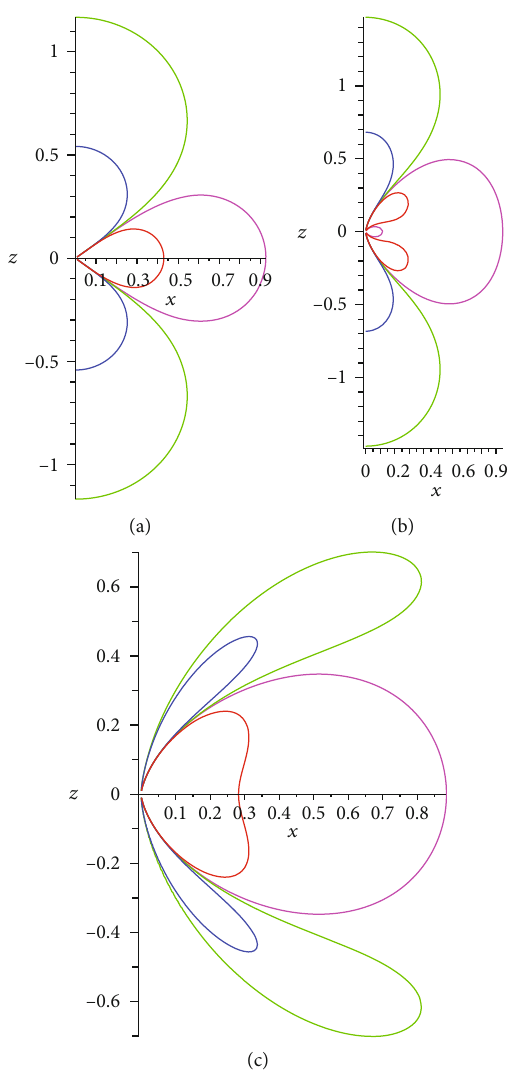
Figure 3: Contours of revolution surfaces around the vertical axis of constant charge density measured in the reference frame at rest with the vertical axis, on the left for a rigid rotating magnetic dipole (Equation (56)); the cases of di ff erential rotation are shown on the center and left, respectively, for charge densities (Equations (59) and (62)). The green curve corresponds to ρ = − 1 , blue is for ρ = − 10 , red for ρ = +10 , and magenta for ρ = +1 . These examples suggest that magnetospheres around astrophysical objects may be quite diverse. Figures were plotted using a = 1 , k = 1 , and Ω 0 = 10